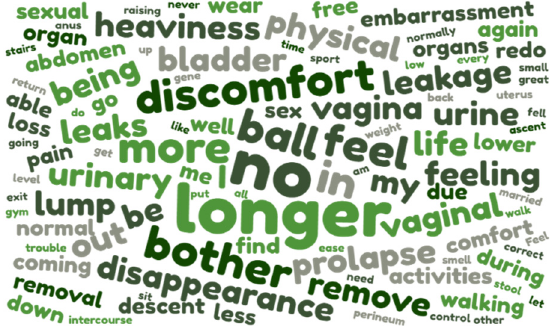
Figure 1. Women’s preoperative hopes before cystocele repair. Table 2. Hope and Fears thematic classification for women and surgeons (examples of responses). Hope Themes